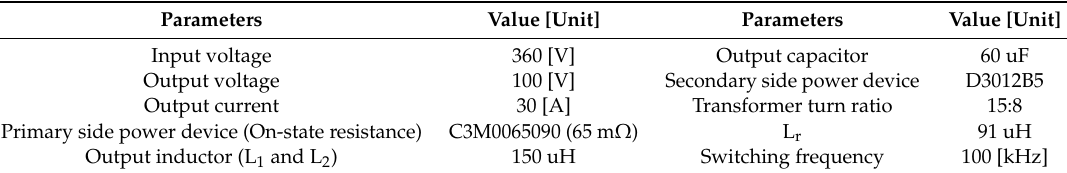
Figure 10. Experiment setup of the proposed 3 kW PSFB converter. Table 2. Specifications of the proposed PSFB converter.